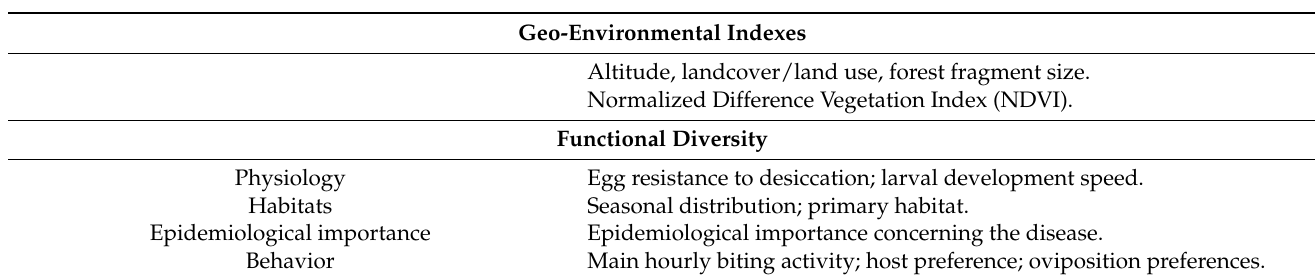
Table 2. Cont. Geo-Environmental Indexes Altitude, landcover/land use, forest fragment